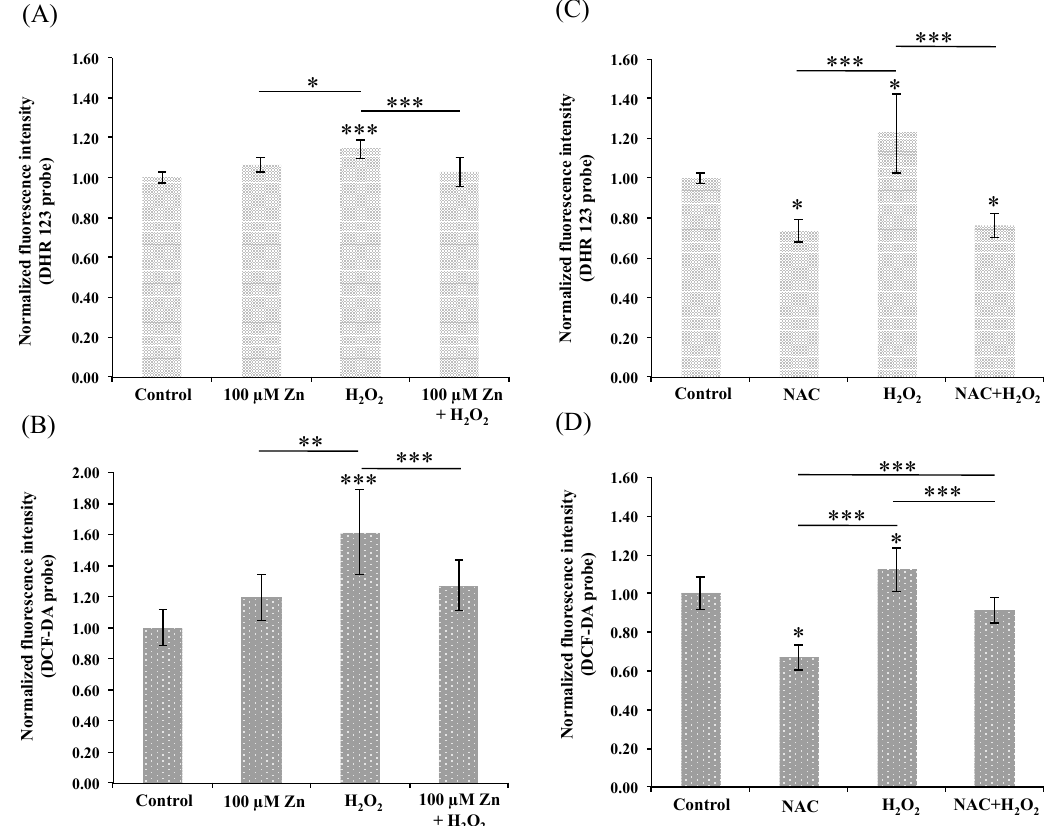
Figure 1. Histograms showing normalized fluorescence intensity of DHR 123 (panels A and C ) and DCF-DA (panels B and D ) probes in different treatment groups of HRPEsv cells, analyzed by a fluorescent plate reader. HRPEsv cells were either: (i) non-treated (see control bar in panels A – D ); (ii) treated with H 2 O 2 (2 mM for 30 min, see H 2 O 2 bar in panels A – D ); (iii) treated with zinc alone (100 µ M for 24 h, see Zn bar in panels A and B ); and (iv) pre-treated wither either 100 µ M zinc for 24 h (see Zn + H 2 O 2 bar in panels A and B ) or (v) 10 mM NAC (see NAC + H 2 O 2 bar in panels C and D ) and followed in both cases by a treatment with H 2 O 2 (2 mM for 30 min), respectively. Mean ± SD is plotted for 6 replicates for each condition. Data analyzed by one-way ANOVA followed by Tukey’s multiple comparison tests. * p < 0.05; ** p < 0.01; *** p < 0.001.